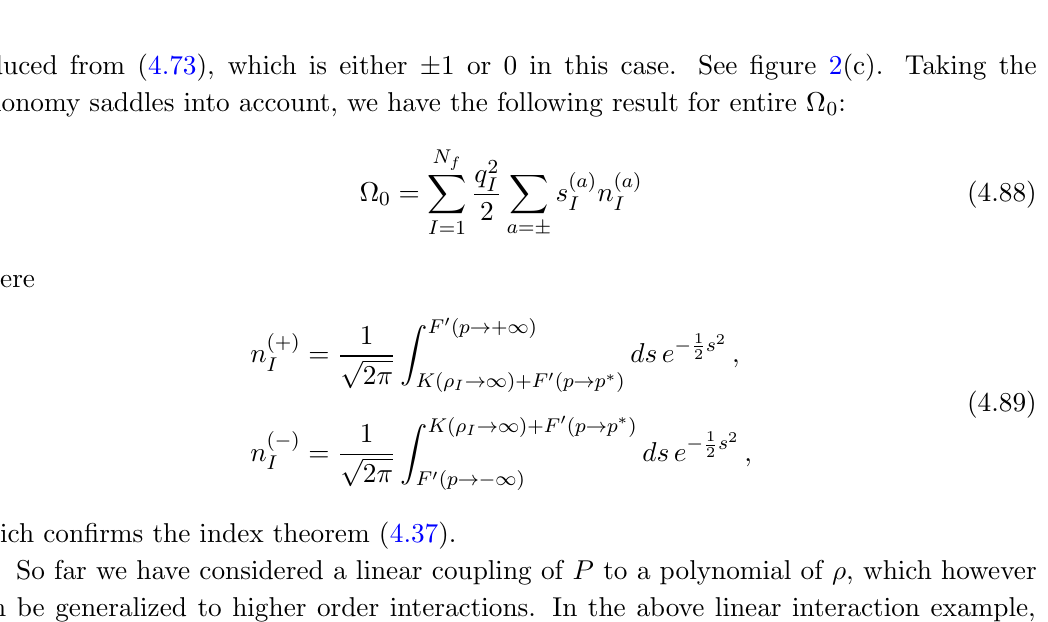
2 , (cid:27) I 2 are (cid:21) (cid:21)